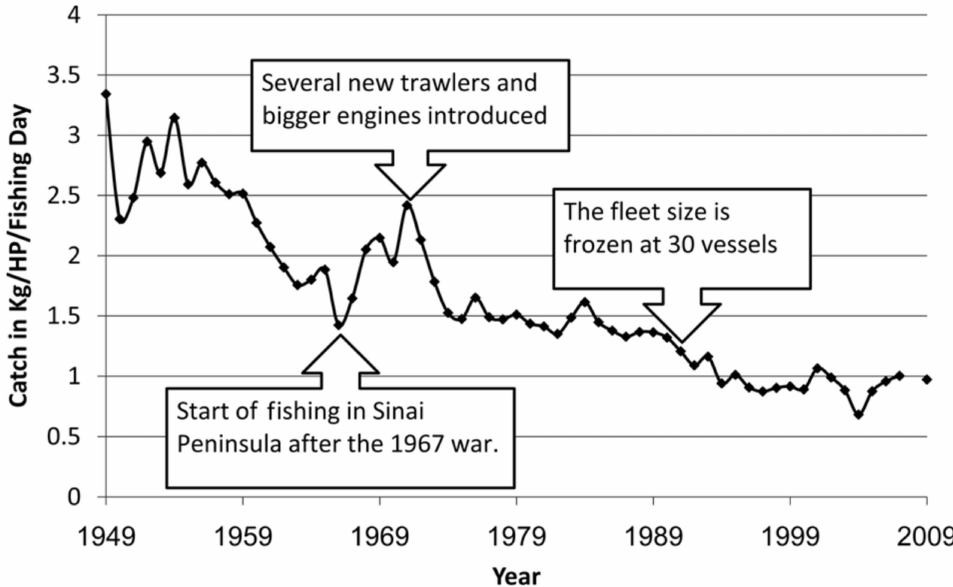
Figure 19. Declines in CPUE (catch per unit effort) of Israeli trawlers based on data collected by the Department of Fisheries of the Israeli Ministry of Agriculture since 1948 (from [160] with